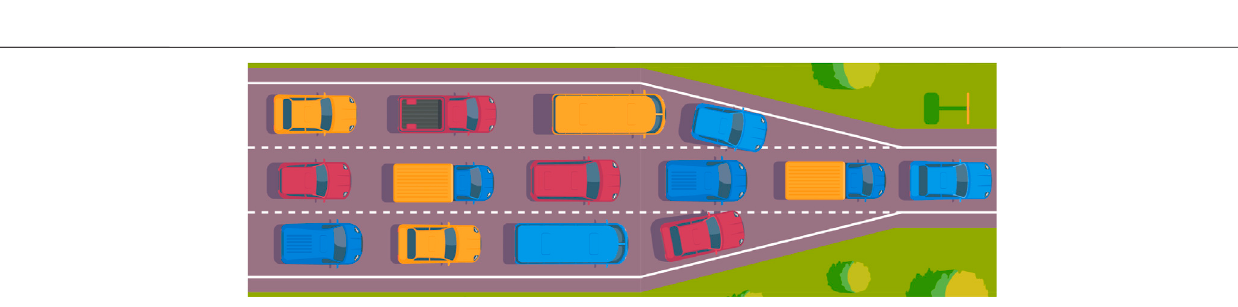
of each connected cluster by using interior point optimization.